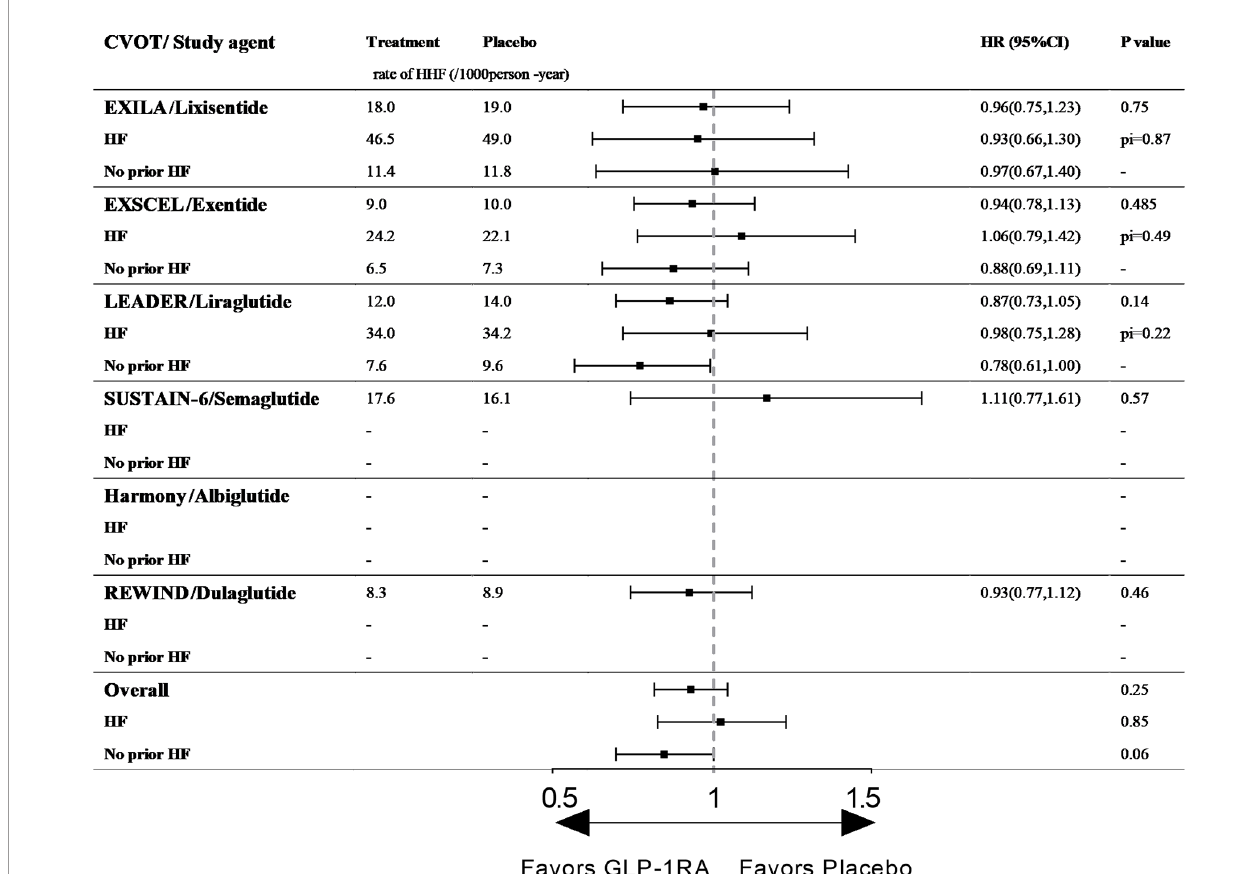
FIGURE 2 | The effect of GLP-1RAs on HHF in type 2 diabetic patients with and without history of HF. CVOT, cardiovascular outcome trial; HHF, hospitalization for heart failure; HF, heart failure; Pi, p value of interaction; ELIXA, The Evaluation of Lixisenatide in Acute Coronary Syndrome; EXSCEL, Exenatide Study of Cardiovascular Event Lowering; LEADER, Liraglutide Effect and Action in Diabetes: Evaluation of Cardiovascular Outcome Results; SUSTAIN-6, Trial to Evaluate Cardiovascular and Other Long-term Outcomes with Semaglutide in Subjects with Type 2 Diabetes; Harmony, Albiglutide and cardiovascular outcomes in patients with type 2 diabetes and cardiovascular disease; REWIND, Dulaglutide and cardiovascular outcomes in type 2